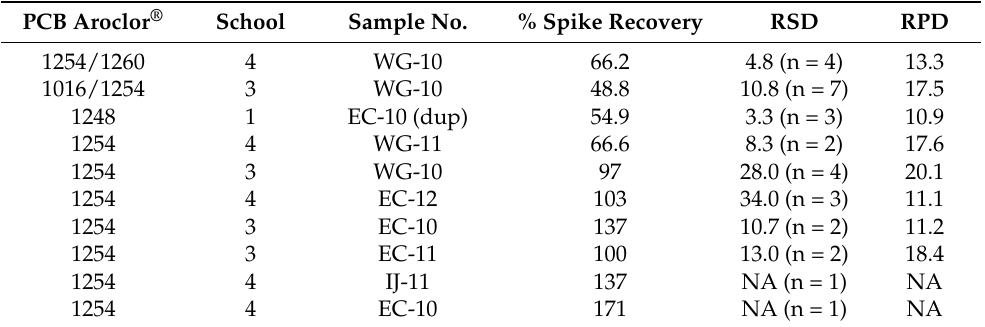
Table 6. PCB Average Percent Spike Recovery, Relative Standard Deviation, and Relative Percent